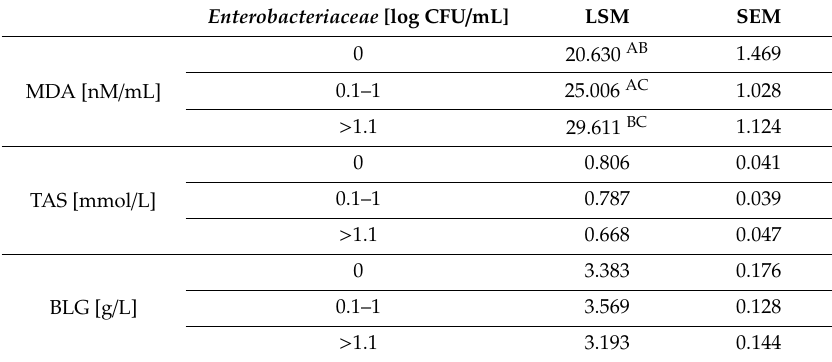
Table 2. Association of Enterobacteriaceae with changes in MDA, TAS and BLG